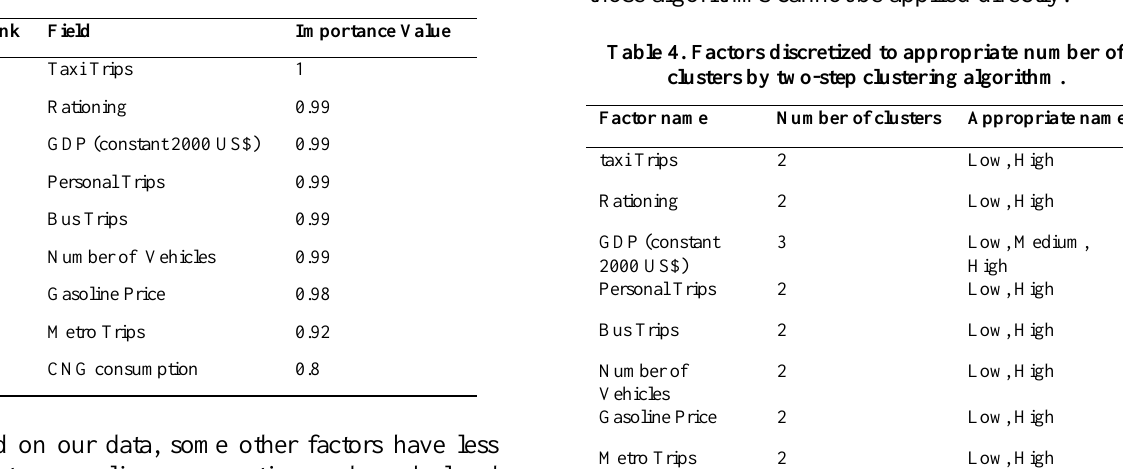
Table 3. Feature selection results.